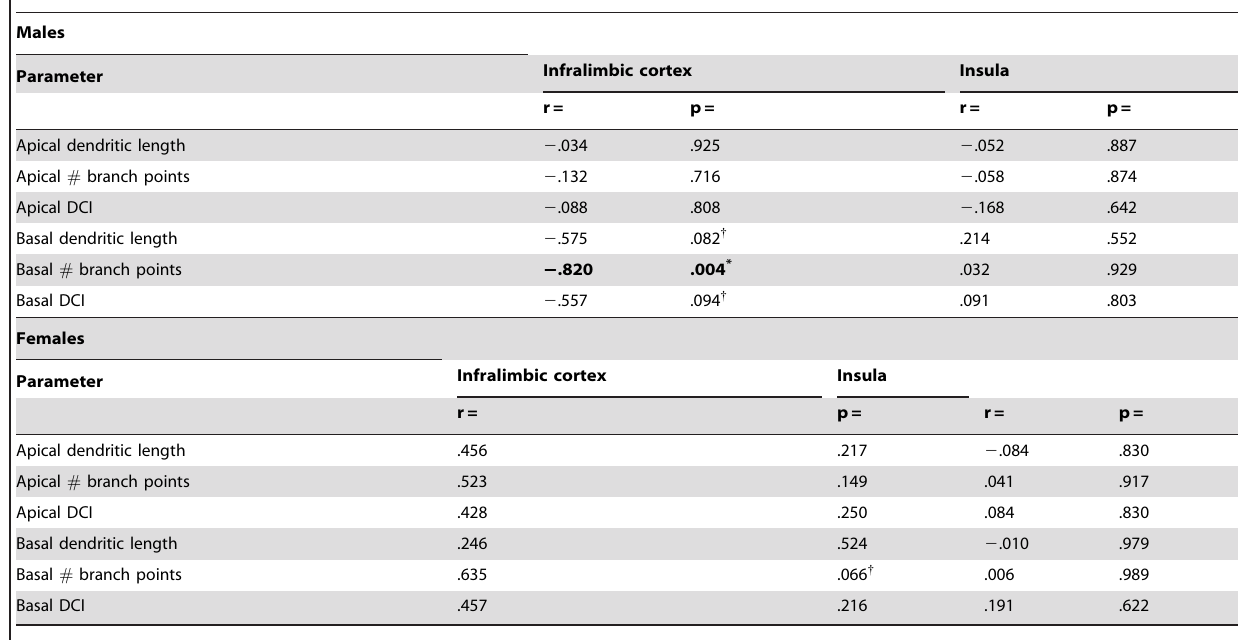
Table 3. Dendritic morphology in 2.5 month old naı¨ve